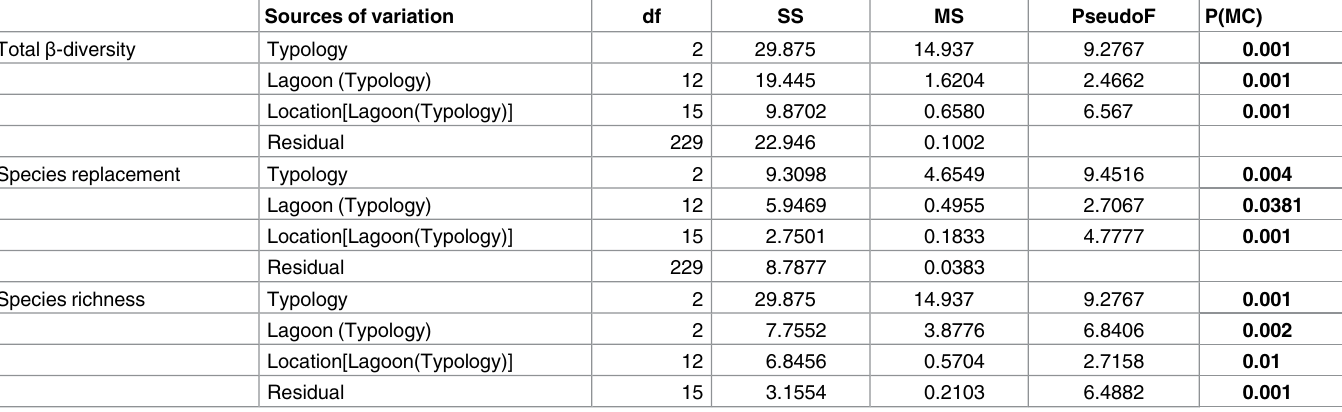
Table 4. Permutational analysis of variance(PERMANOVA) results of the effectsof lagoon typology (Open, ICCOL and Closed), lagoons (5 open, 5 ICOLL and 5 closed) and location (inner and outer) on the total β -diversity and decomposed replacementand richness